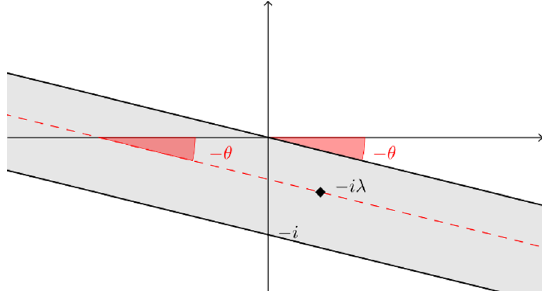
Figure 21 . Choice of integration contour for the Mordell integral (cid:9) + . The angle 0 < (cid:18) < (cid:25) arbitrary, and (cid:0) i(cid:21) must lie in the shaded region.